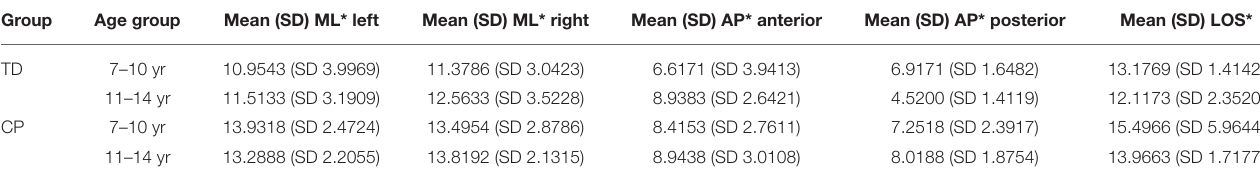
TABLE 2 | Mean and SD of baseline postural control tests for each age group. Group Age group